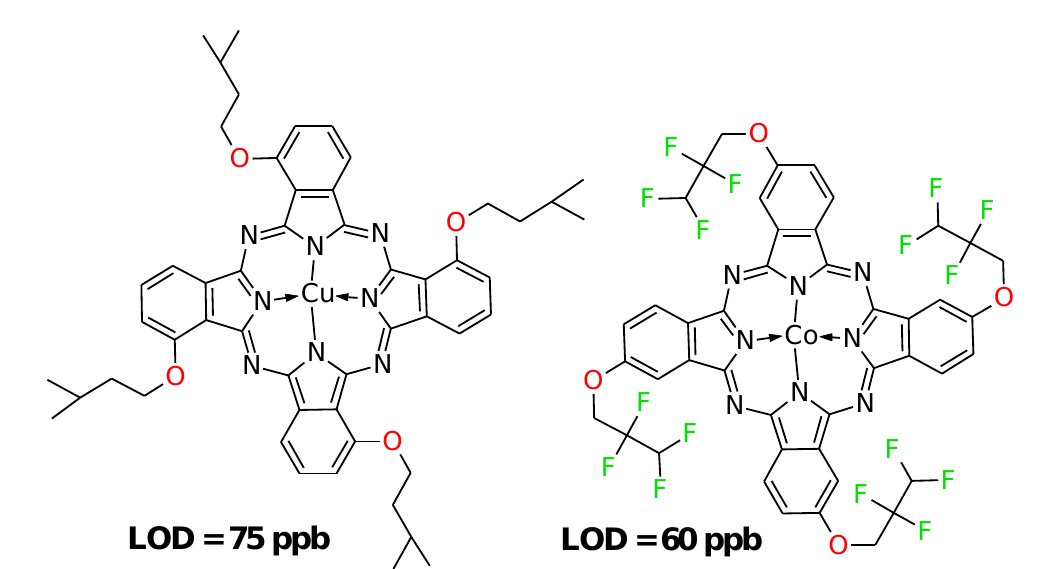
Figure 3. The chemical structures of two phthalocyanines with the lowest limit of detection (LOD) in ammonia sensing [39,40].